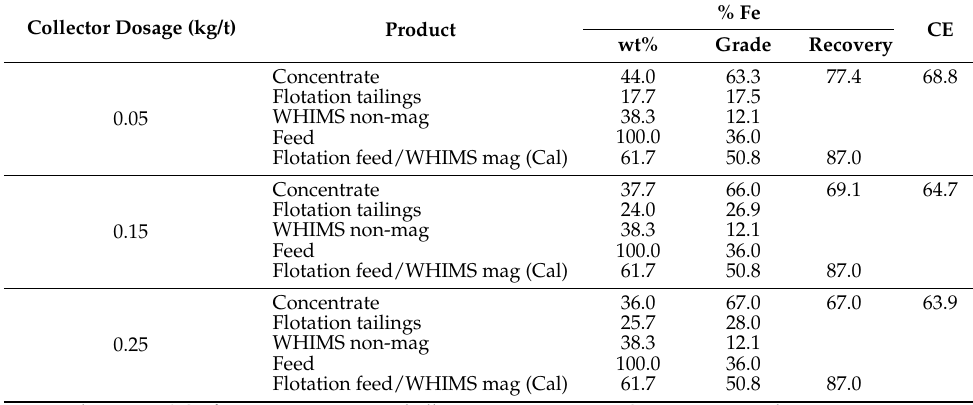
Table 8. Effects of collector dosage on reverse flotation of WHIMS